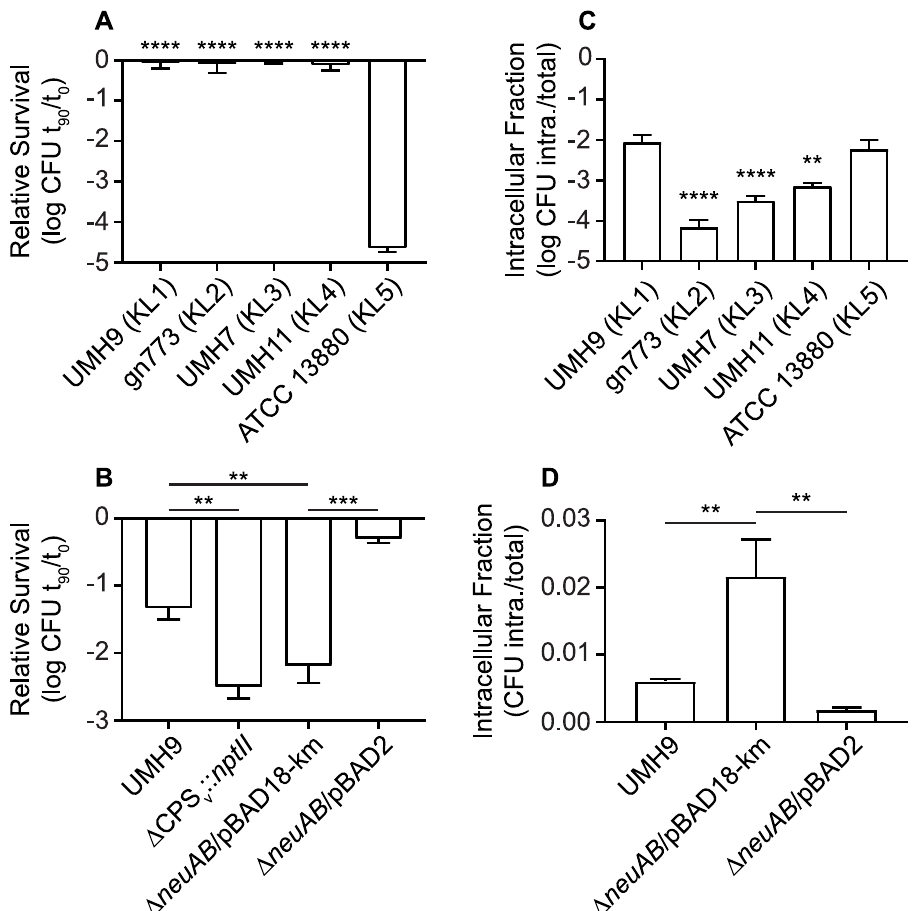
Fig 13. Serum susceptibility and phagocyte internalization of S . marcescens strains. (A) Bacteria were exposed to 40% pooled human serum for 90 minutes. Viability was calculated relative to the number of bacteria present at the start of the experiment. Differences in serum sensitivity were assessed by one-way ANOVA with Dunnett’s multiple comparisons test relative to strain ATCC 13880. (B) Serum sensitivity of UMH9 capsule mutant strains was determined as described for panel A and an unpaired t test was used to determine statistical significance. (C) Adherent U937 cells were infected with S . marcescens strains at an MOI of 20. The proportion of intracellular bacteria was determined relative to the total bacterial inoculum after a 1 h treatment with gentamicin to kill extracellular bacteria. A one-way ANOVA with Dunnett’s multiple comparisons test relative to ATCC 13880 was used to assess statistical significance. (D) Internalization of the UMH9 capsule mutant strain by U937 cells was tested as described for panel C. A unpaired t -test was used to determine statistical significance. Symbols: �� , P < 0.01; ��� , P < 0.001; ���� , P < 0.0001.